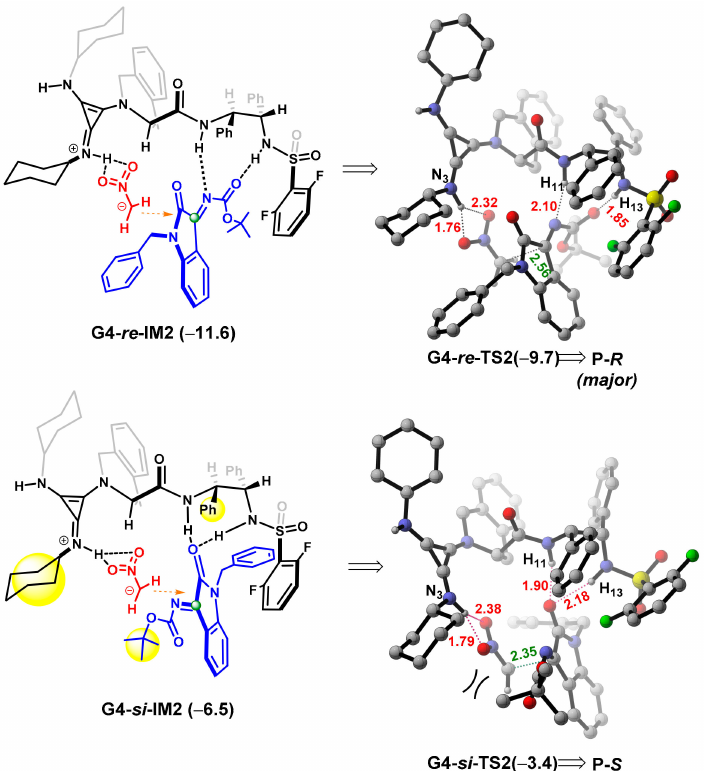
Figure 11. Optimized structures and the relative Gibbs free energies (in kcal · mol − 1 ) of two competing transition states (G4- re -TS2 and G4- si -TS2) in the C–C bonding formation step of the aza-Henry reaction catalyzed by G4. The distances are in